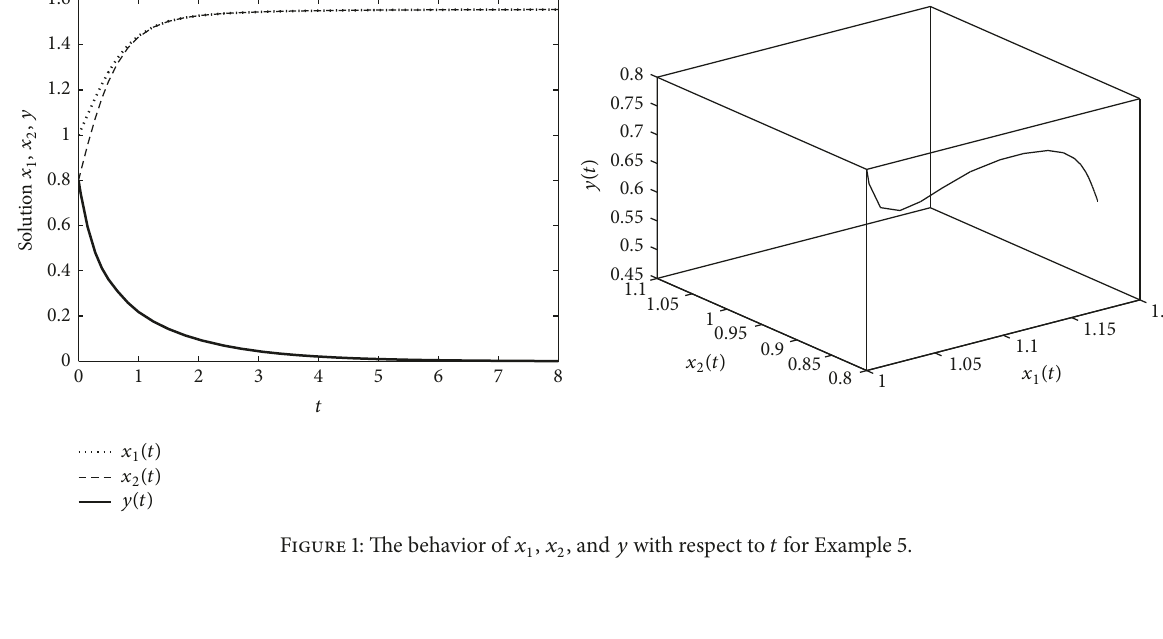
Figure 1: The behavior of 𝑥 1 , 𝑥 2 , and 𝑦 with respect to 𝑡 for Example